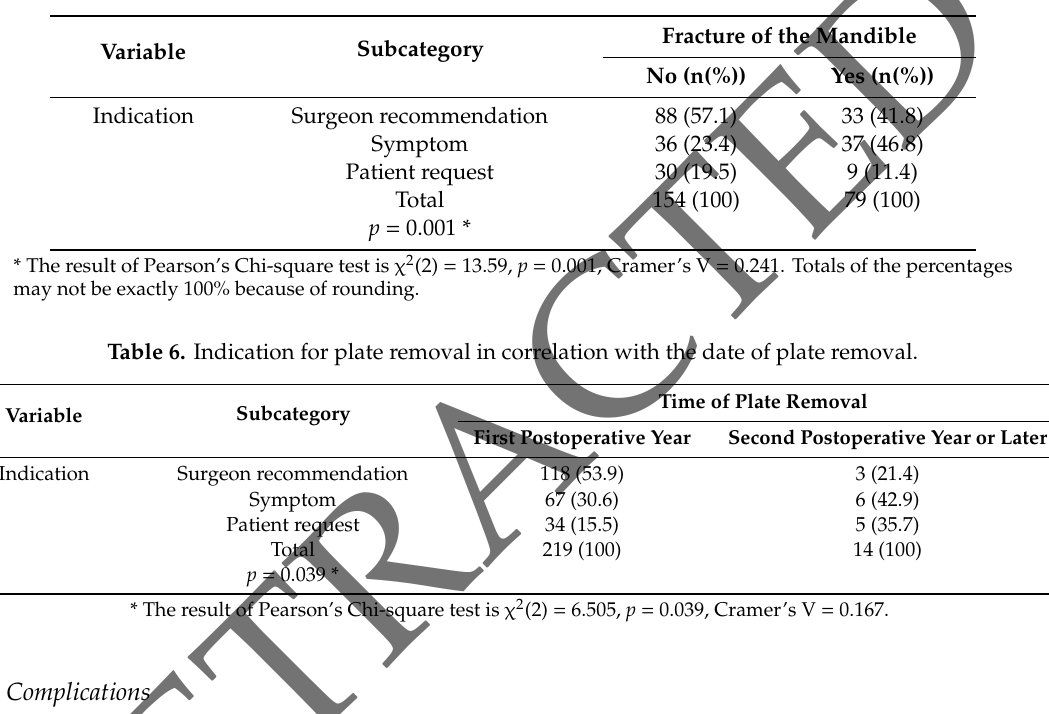
Table 5. Indication for plate removal in correlation with fractures of the mandible. Significantly more patients underwent symptomatic plate removal after mandibular fractures (46.8%, n = 37, Pearson’s chi-square test, p = 0.001) than fractures elsewhere.